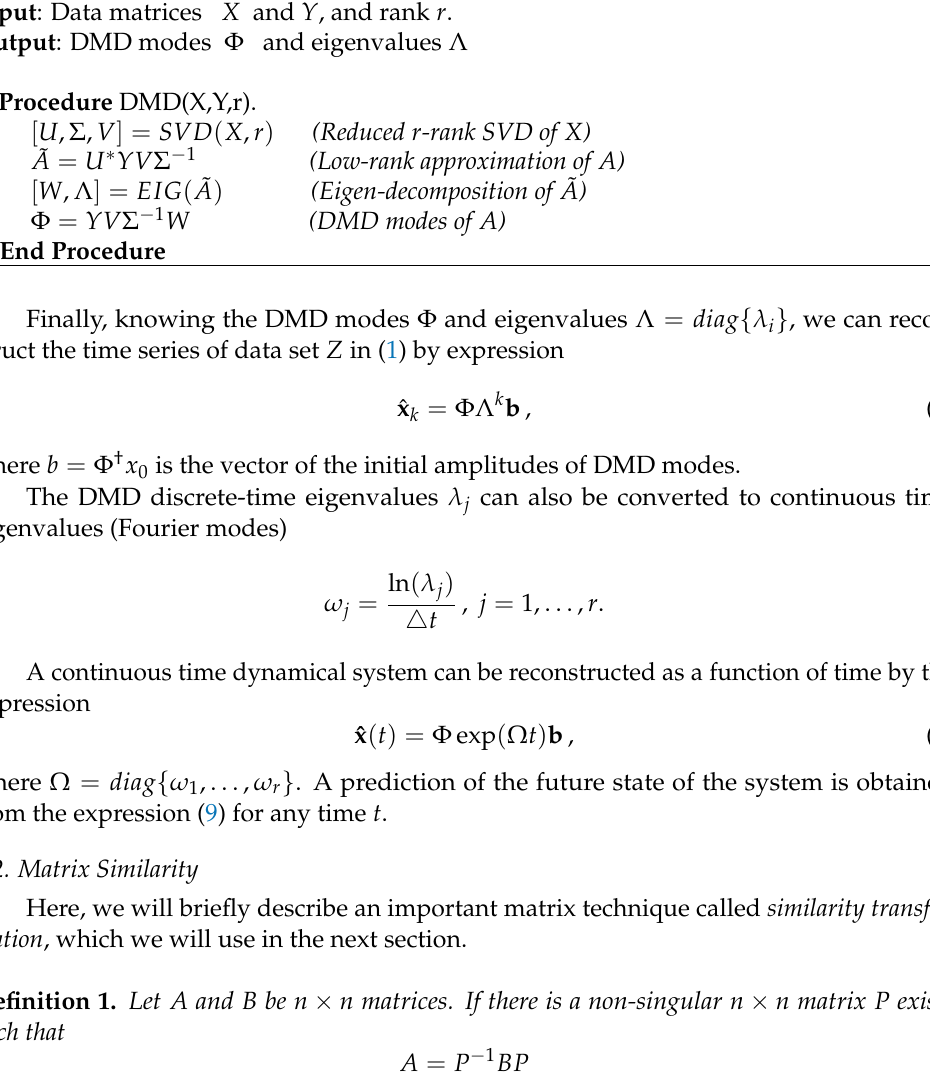
Algorithm 1 Exact